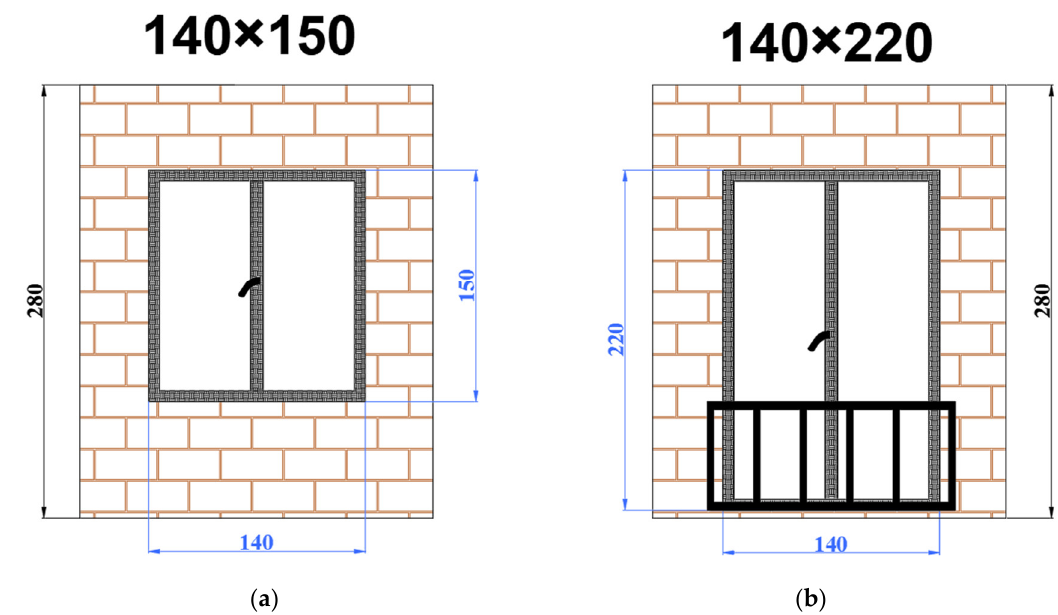
Figure 3. Window types ( a ) h = 150 cm and ( b ) h = 220 cm.